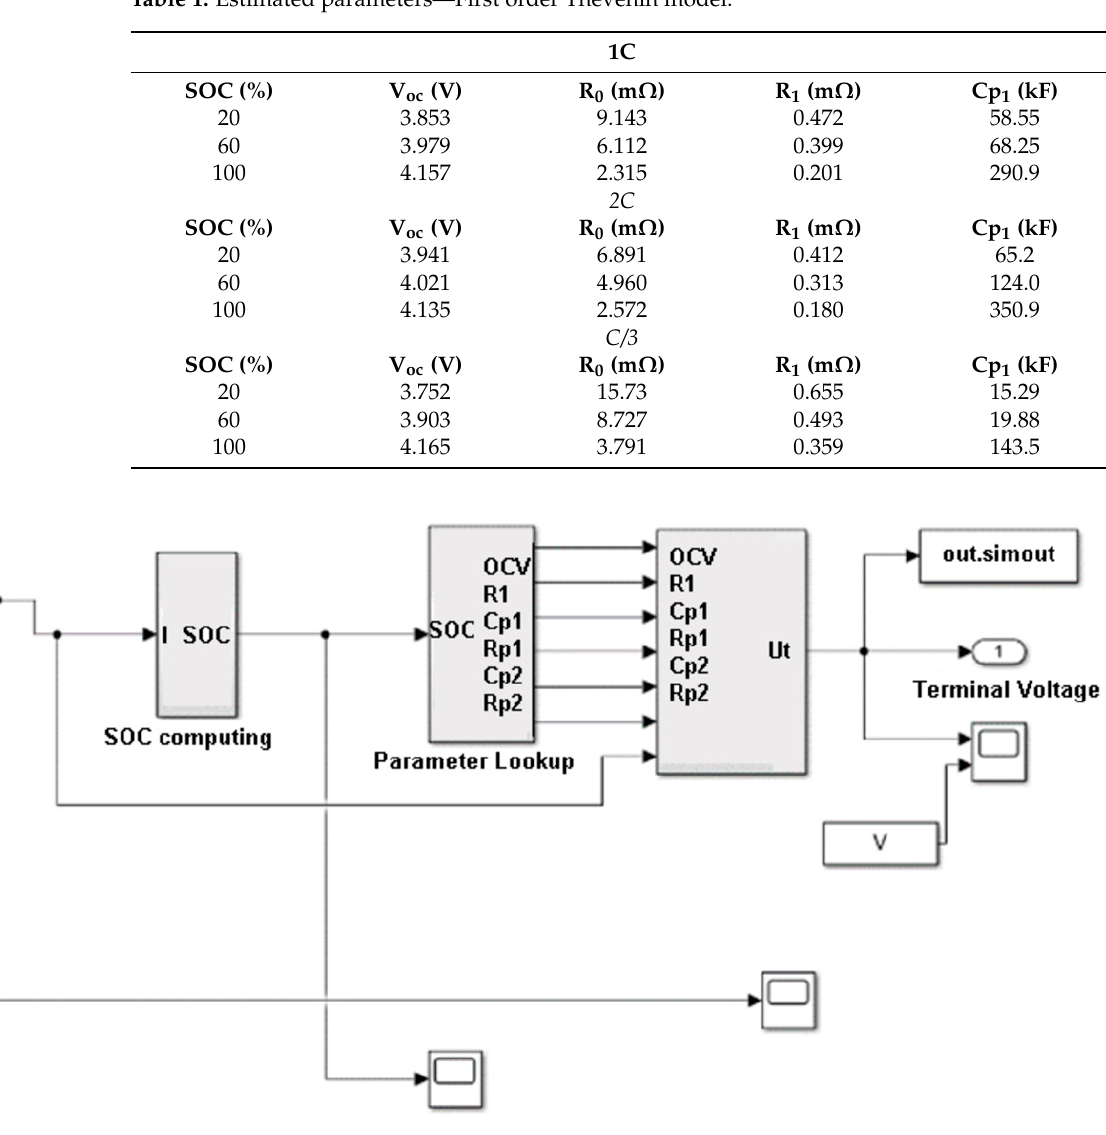
Figure 2. Simulation model for the second order RC circuit.